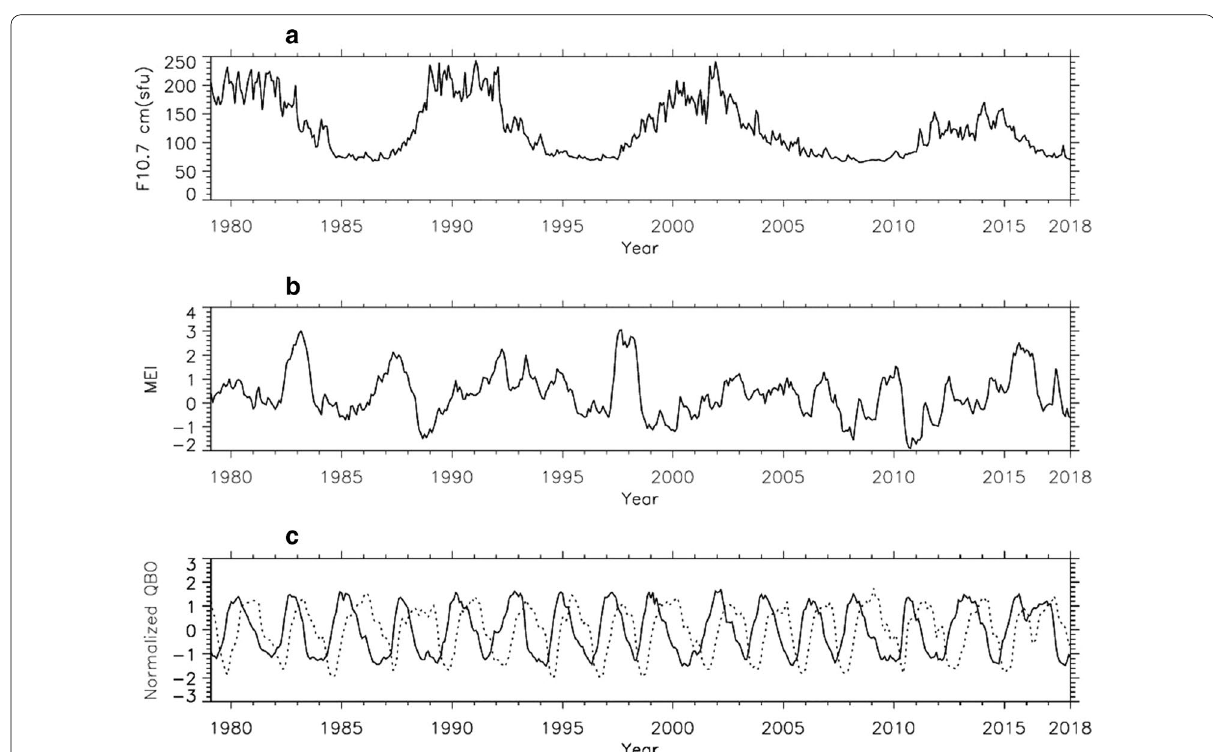
Fig. 2 Time series of the ( a ) SC index (F 10.7 cm flux), ( b ) multivariate ENSO index (MEI), and ( c ) QBO indices on a monthly basis from February 1979 to January